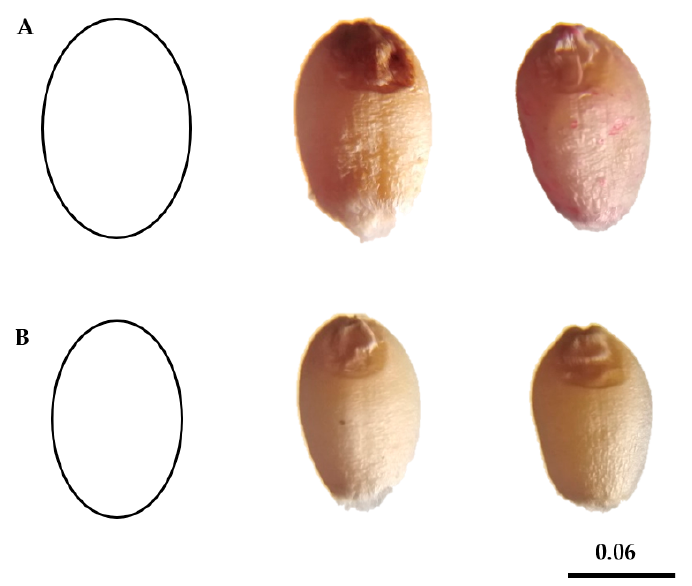
Figure 2. Two geometric models of wheat kernels are ( A ): an ellipse of aspect ratio = 1.8 (more rounded) for W2 and W16 genotypes (from left to right) and ( B ) an ellipse of aspect ratio = 2.03 (more nearly elongated) for W12 and W14 genotypes (from left to right). Bar corresponds to 0.06 cm.